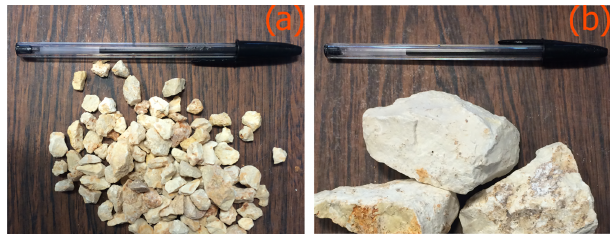
Figure 2. Samples of the materials used for the experiments with